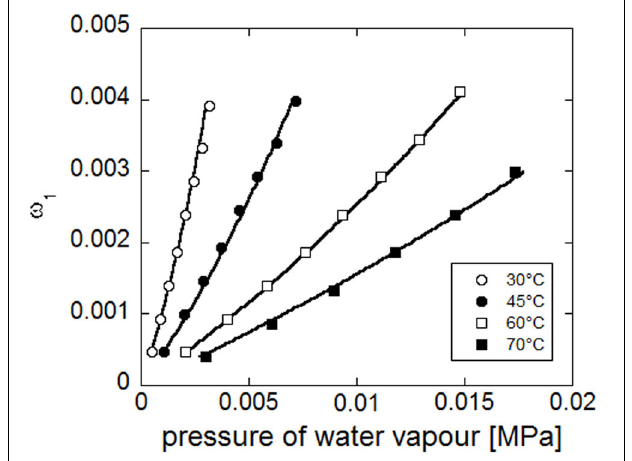
FIGURE 13 | Fitting of experimental water sorption isotherms for PEEK, reported as water mass fraction in the amorphous phase vs. pressure of water vapor. Continuous lines represent fitting curves provided by NETGP-NRHB model.